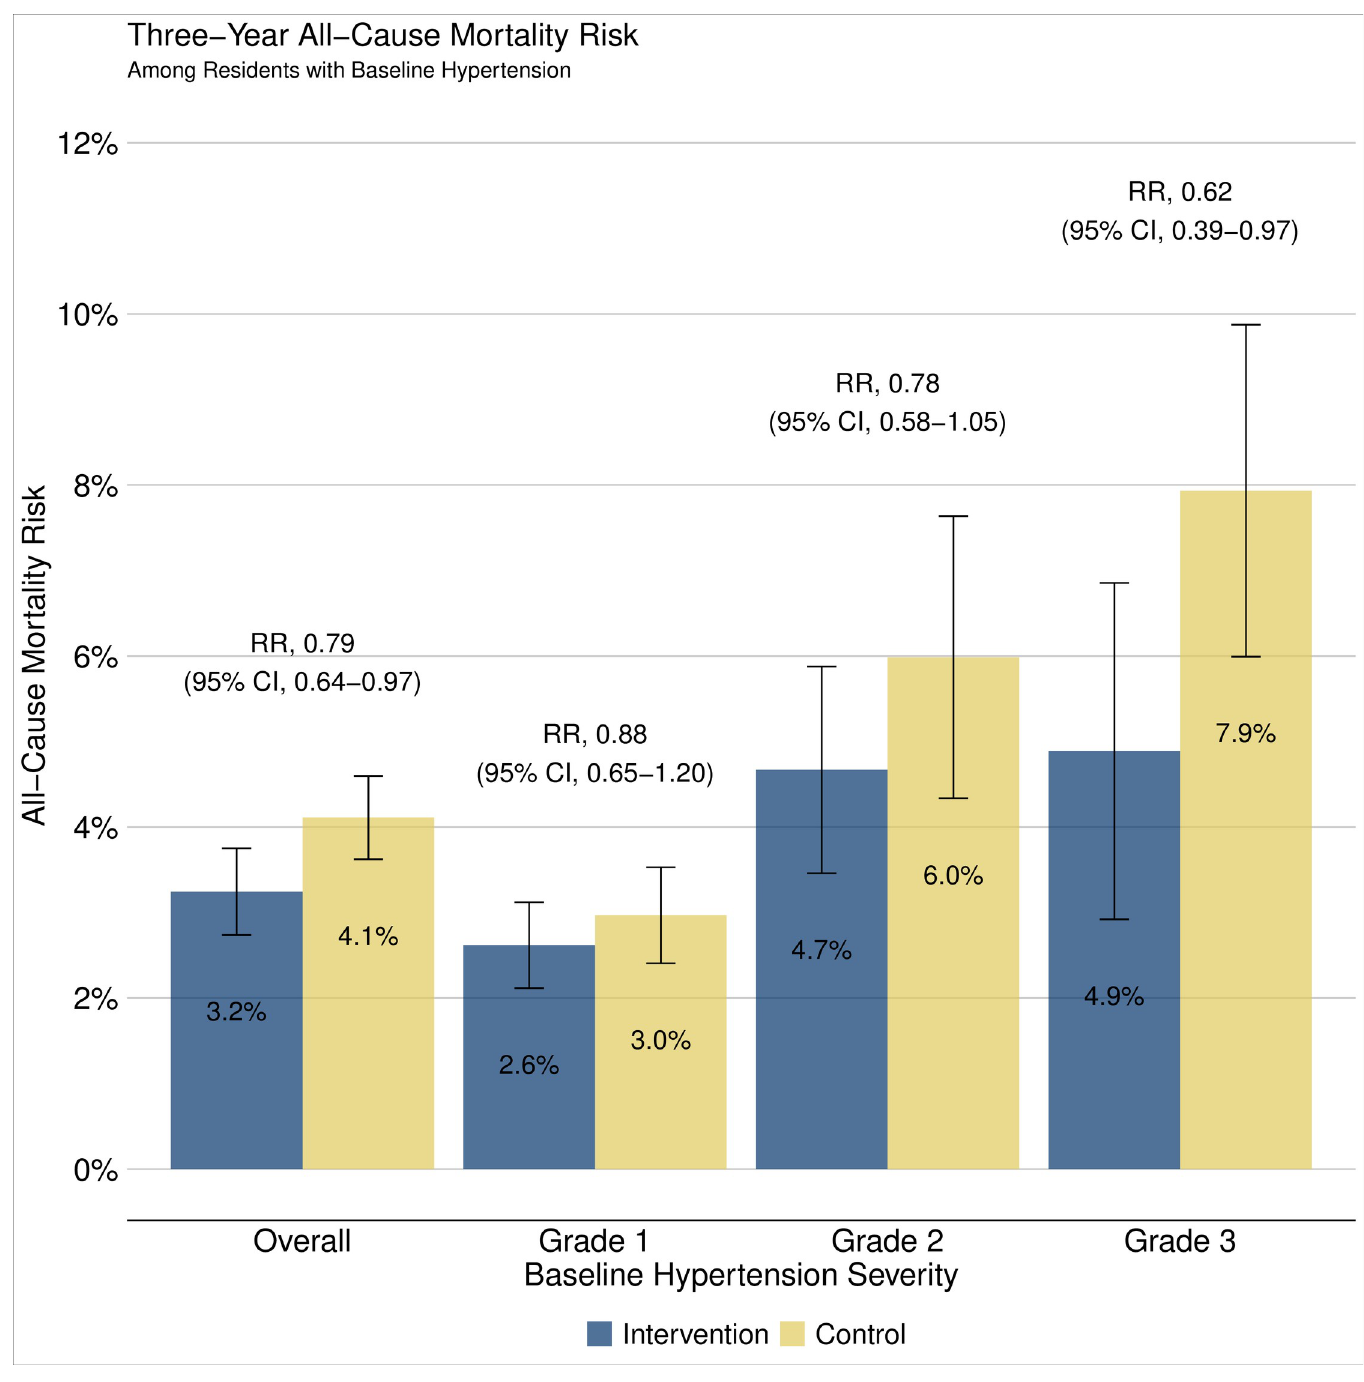
Fig 2. Cumulative incidence of mortality by year 3. Estimates obtained using 2-stage TMLE to estimate and compare community-level mortality by 3 years. Vertical error bars depict arm-specific 95% CIs. Baseline hypertension severity defined by lowest of 3 BP measurements and classified as Grade 1 (BP 140–159/90–99 mm Hg), Grade 2 (BP 160–179/100–109 mm Hg), Grade 3 (BP � 180/110 mm Hg). BP, blood pressure; CI, confidence interval; RR, relative risk; TMLE, targeted maximum likelihood estimation.